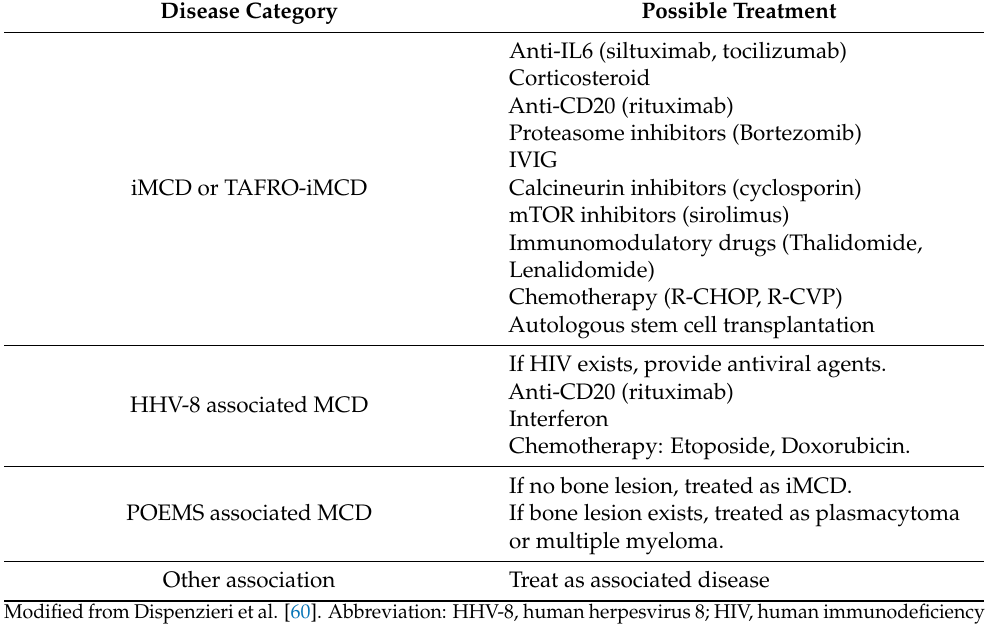
Table 3. Current treatment options of Castleman disease and associated